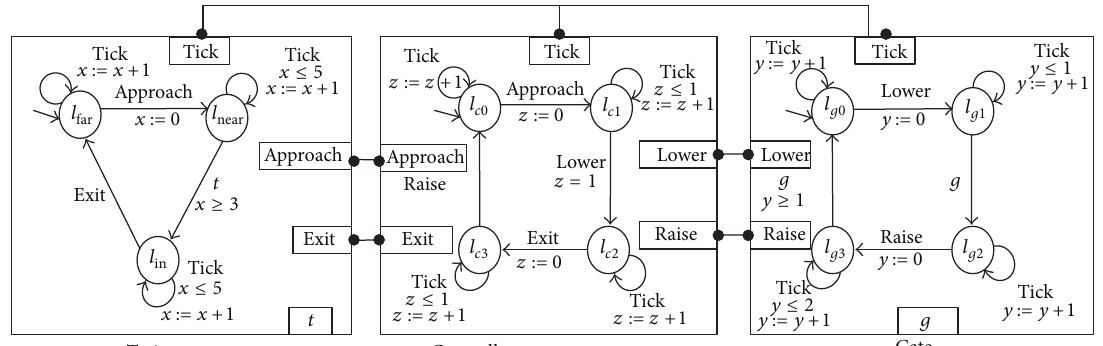
Figure 2: The component-based model for train gate controller